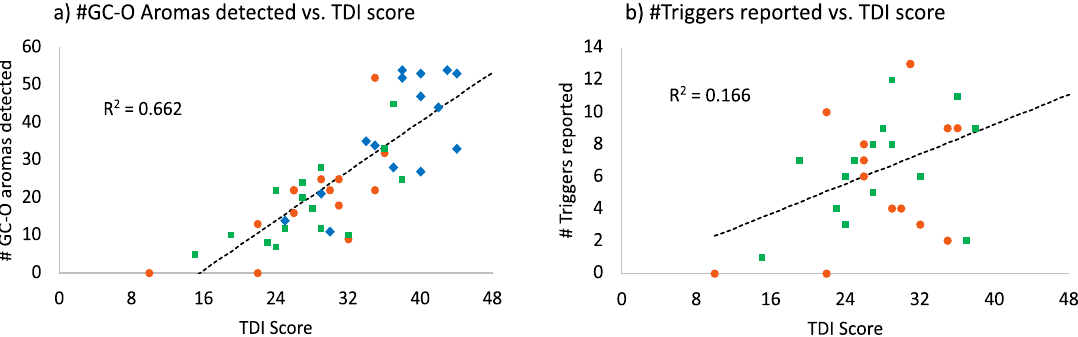
Fig. 1 Correlations between olfactory function and GC-O. a Correlation between TDI score (Threshold, Discrimination, and Identi fi cation Snif fi n ’ Sticks test score) and number of aromas detected at the GC odour-port. b Relationship between number of triggers detected in the coffee extract and TDI score. In both fi gures, non-parosmic participants = blue, pre-COVID-19 parosmic participants = orange, post-COVID-19 parosmic participants = green. Source data in Supplementary Data 2.